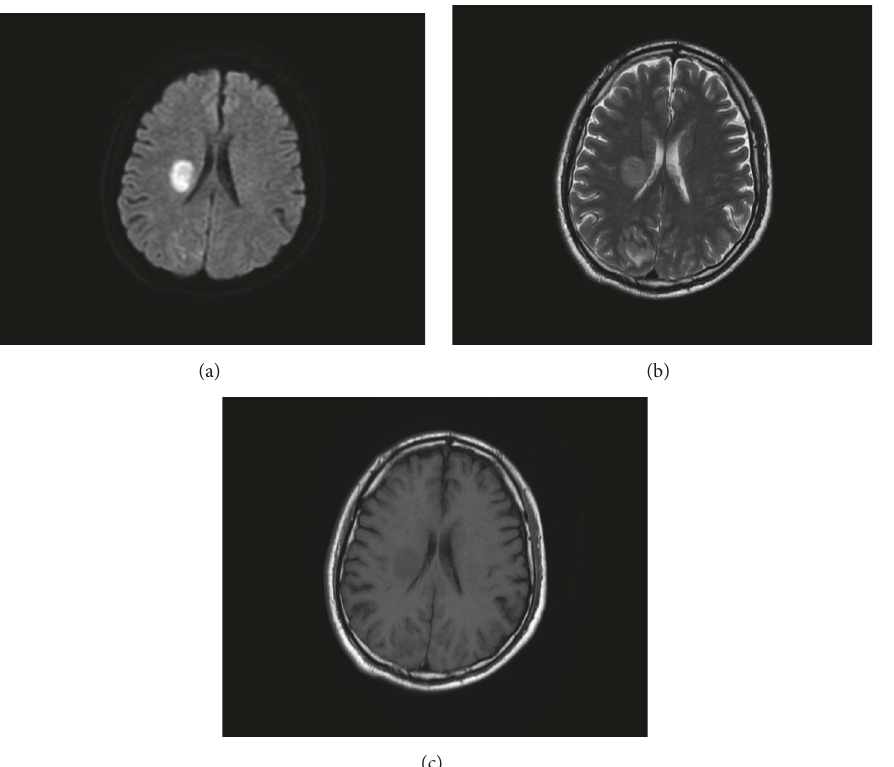
Figure 3: Brain MRI performed on the third day revealed (a) high signal intensity on DW image and (b, c) well-defined rounded cystic lesion on the T2-weighted and T1-weighted images involving in the right corona radiata and basal ganglia, compressing the right lateral ventricle with midline shift to left, suggestive of an early stage of brain abscess.